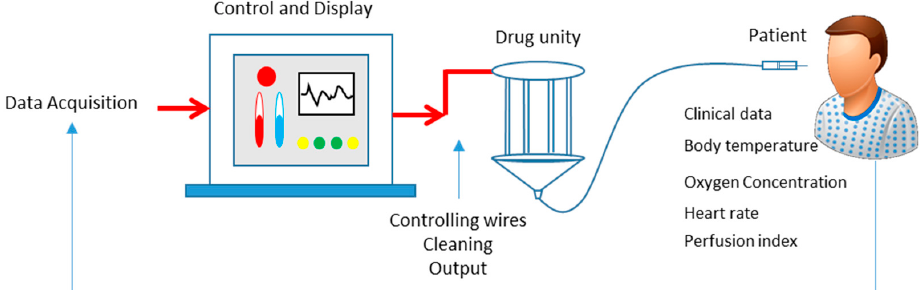
Figure 9. A monitoring system and overview of medication control.